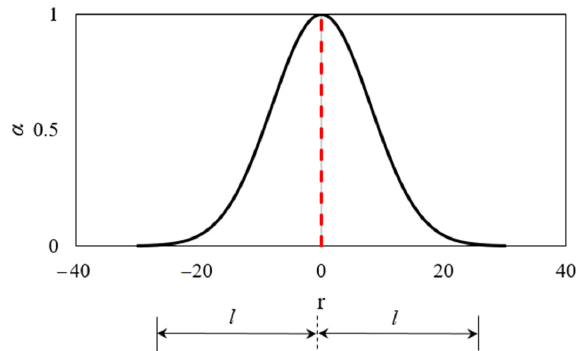
Figure 2. Modified Gauss weight function used for the calculation of nonlocal temperature.